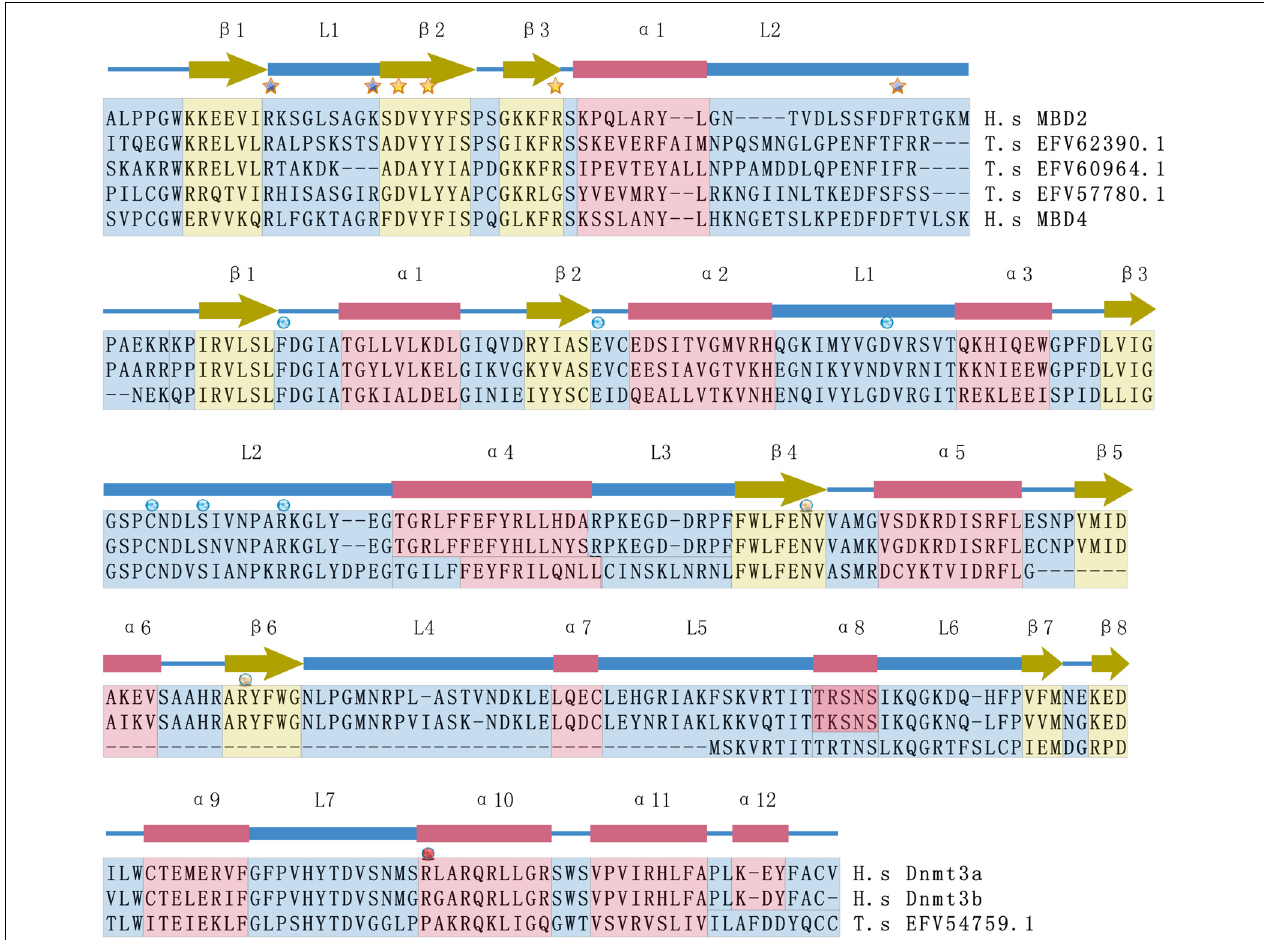
FIGURE 2 | Comparison of the secondary structures of MBD domains and Dnmt3 catalytic domains between T. spiralis and H. sapiens . The secondary structures of human MBD2 and Dnmt3a are indicated as blocks, including alpha helices ( α ), beta sheets ( β ), and loops (L), that are marked with different colors (blue = alpha helices, yellow = beta sheets, and red = loops). Important residues responsible for methyl-CpG binding are marked with asterisks. The functional sites of